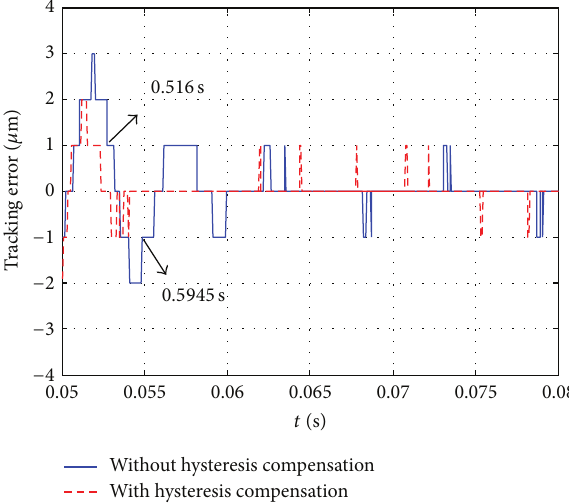
Figure 13: Comparison of the position tracking error in the stop